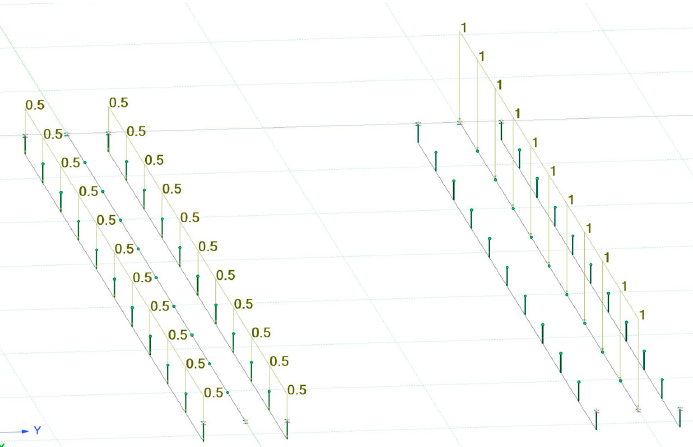
Figure 5. Calculation scheme in the software package Lira-Soft 10.12. Three bar elements are presented: a central rib and two side shelves. The shelves are set with a vertical offset due to rigid kinematic inserts. Two options for applying loads are given: on the shelves at 0.5 kN/m and on the central rib 1 kN/m.